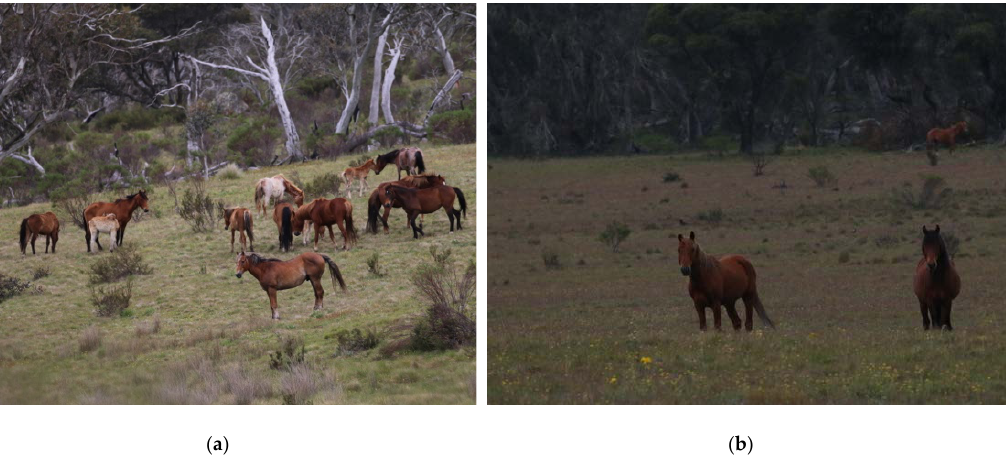
Figure 10. Horses are highly social animals exhibiting a harem social structure: ( a ) the social unit, known as a band, and ( b ) a group of bachelor stallions, in Kosciuszko National Park, NSW, Australia. Images A. M. Harvey.